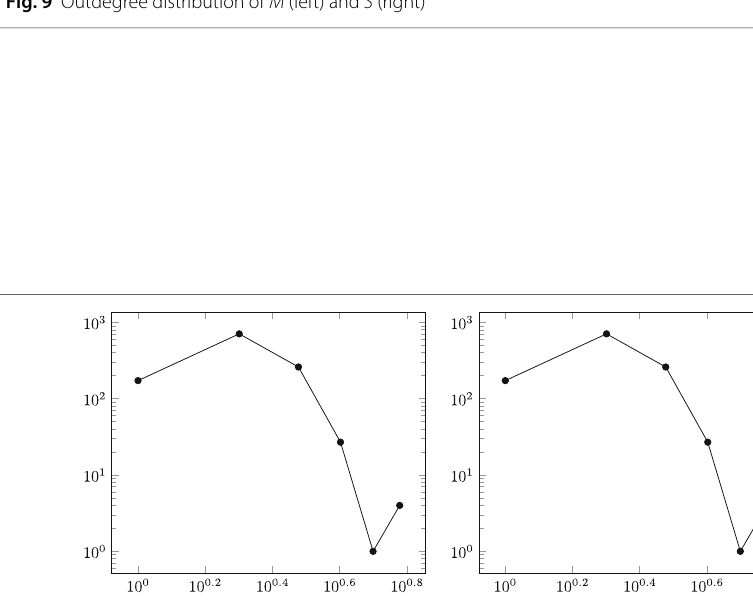
Fig. 10 Tail size distribution of M (left) and S (right)